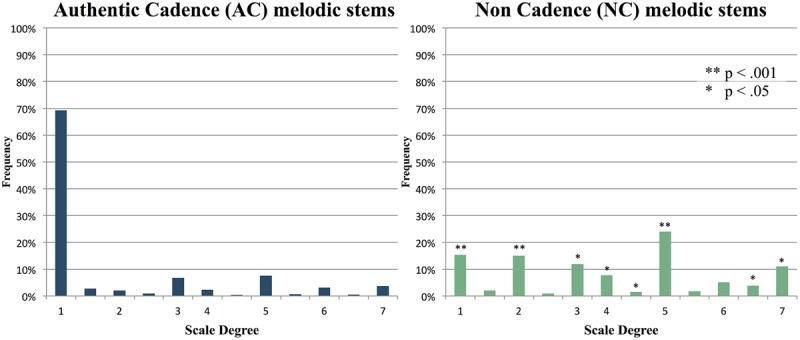
Average of all response distributions to AC and NC stems, shown as scale degrees. Numbers represent diatonic (major) scale degrees (e.g., 1 = tonic, 7 = leading tone, etc.), with asterisks indicating scale degrees with significantly different frequencies between the two conditions.